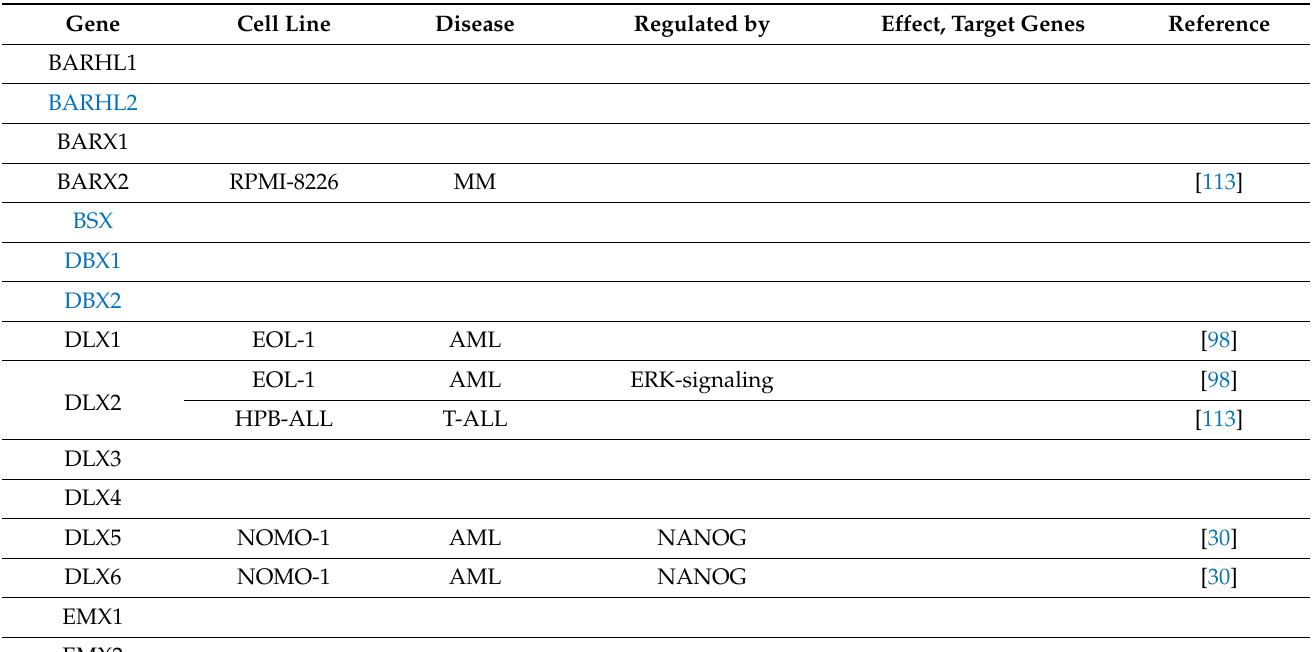
Table 2. Aberrantly expressed NKL homeobox genes in leukemia/lymphoma cell lines. This table lists hematopoietic cell lines in which particular NKL homeobox genes are overexpressed. Additionally, the corresponding disease and potentially relevant information are given. NKL-code members are indicated by gray background, genes not represented on the analyzed expression array are indicated in